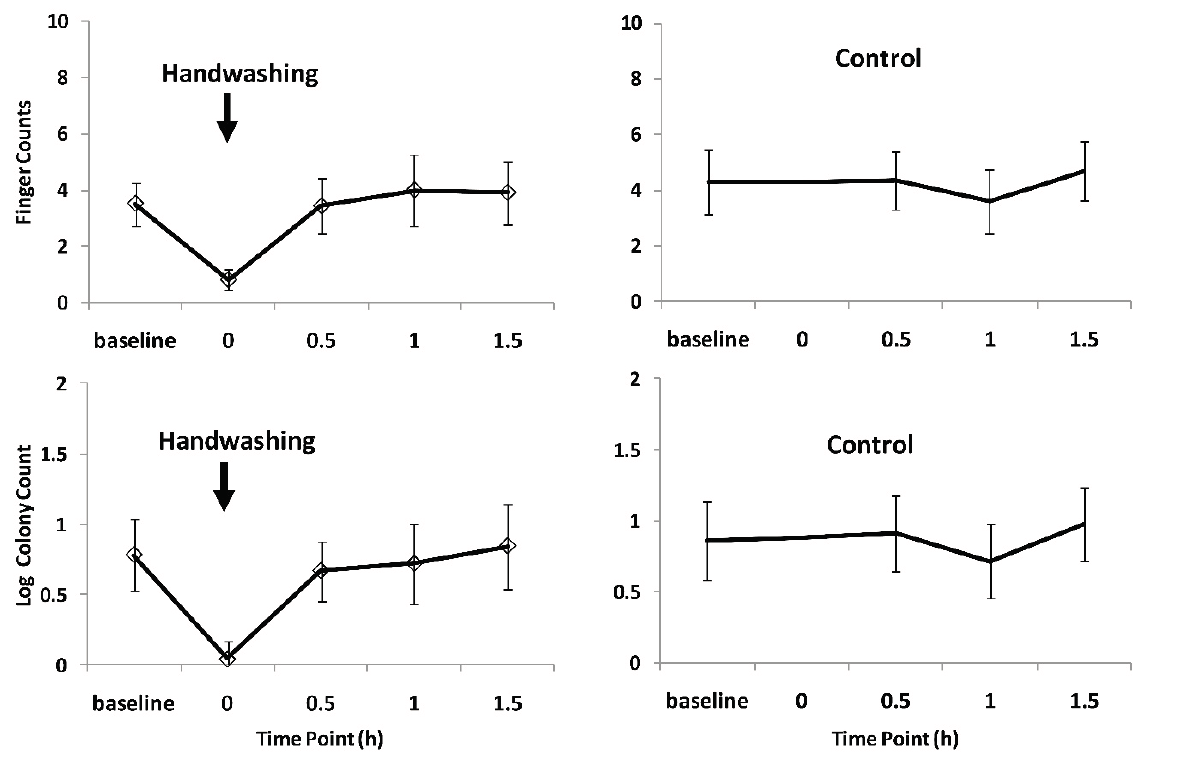
Table 1. Longitudinal recontamination study: comparison between the hand washing and control at each time point (for each model N = 46 person-rounds in 14 mothers). Difference in Mean Finger Counts and Mean Log Colony Counts between Hand Washing and Control ( p -Value) * Time Point Enterococcus Enterococcus FC E. coli FC E. coli LogCC LogCC Baseline − 0.87